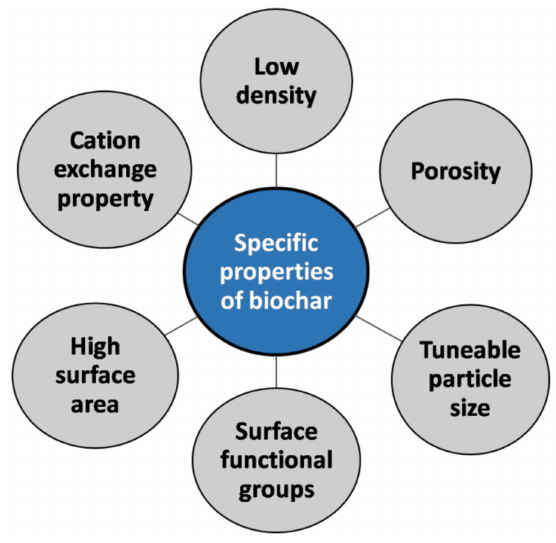
Figure 3. Specific properties of